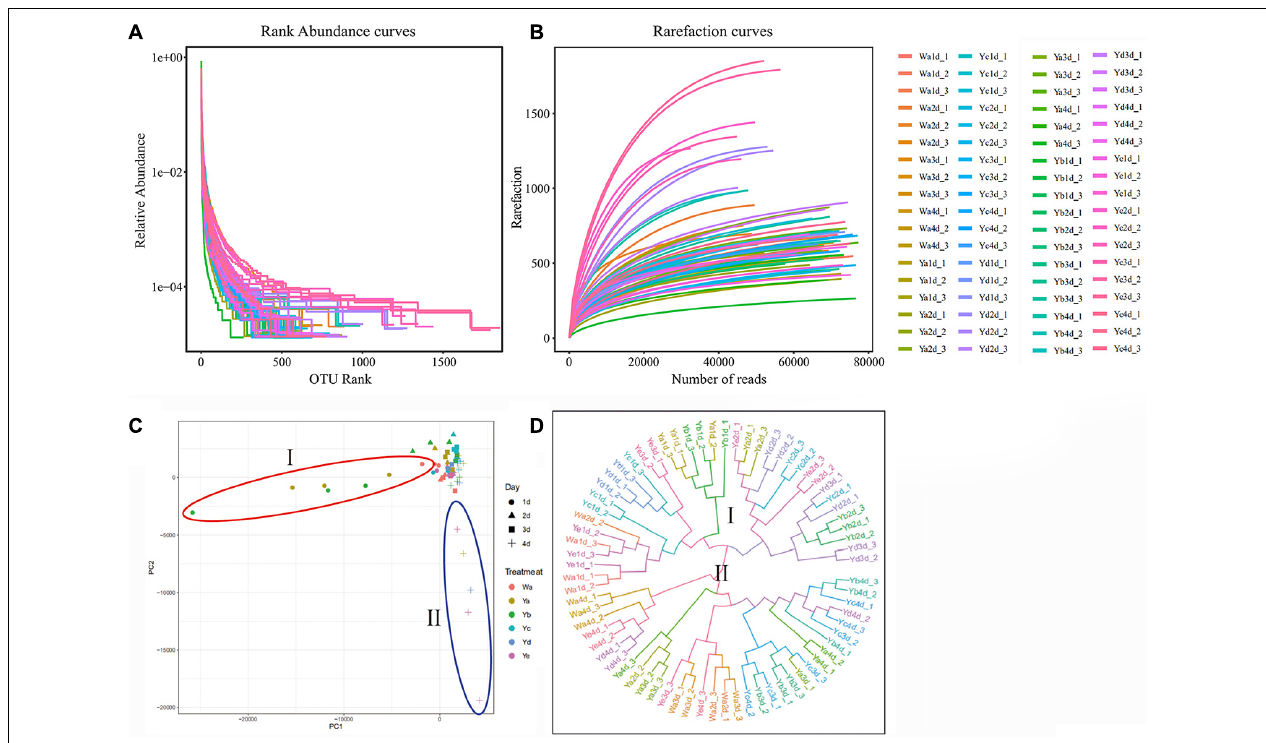
FIGURE 2 | Species rarefaction analysis of sample sequences and differences in bacterial community structures among different groups. Species rank-abundance curve (A) and rarefaction curve (B) analysis of sample sequences. (C) Principal coordinate analysis (PCoA) of bacterial community structures of the different groups. (D) UPGMA tree analysis of evolving samples. Each symbol represents one sample of different dilutions of P. aeruginosa. Wa, Ya, Yb, Yc, Yd, and Ye represent housefly larvae samples fed diets with sterile water, P. aeruginosa stock solution, and the stock solution diluted 10 2 , 10 4 , 10 6 , and 10 8 fold,